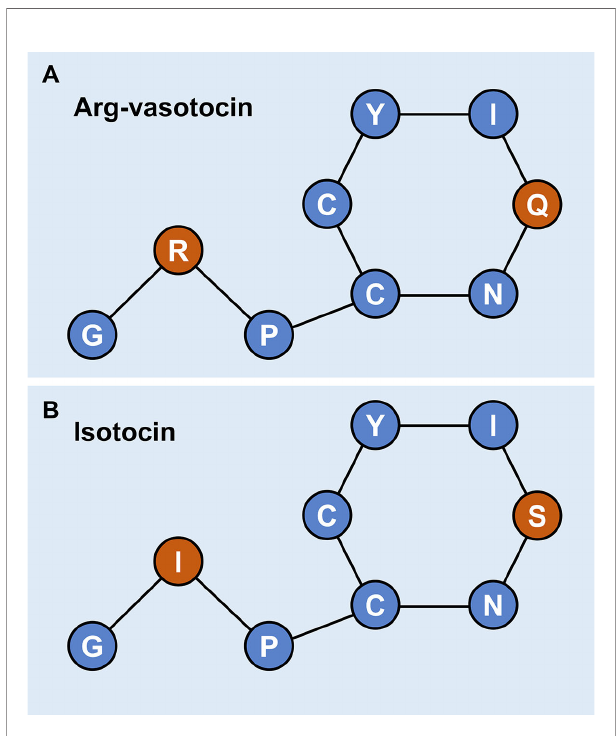
FIGURE 3 | Schematic diagrams of the primary structures of guppy AVT (A) and IT (B) . Different amino acids at positions 4 and 8 are highlighted in